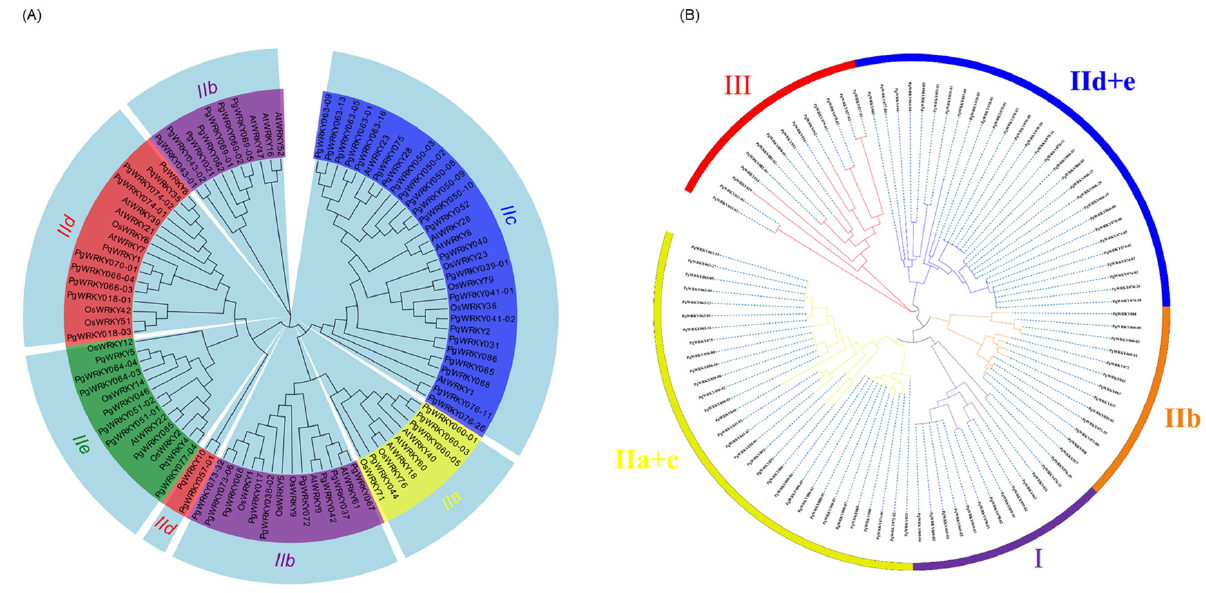
Figure 3. Phylogenetic tree of the PgWRKY gene family. ( A ) The total of 91 PgWRKY genes in subgroup II that had complete ORFs and were used as representatives to construct the classification and phylogeny with 3 other species 53 WRKY genes (Table S3). Yellowish in the inner circle indicates the WRKY genes Group II-a; Purple in the inner circle the WRKY genes Group II-b; Blue in the inner circle the WRKY genes Group II-c; Red in the inner circle the WRKY genes Group II-d; Green in the inner circle the WRKY genes Group II-e. The total of 53 WRKY genes from Arabidopsis thaliana ( AtWRKY ), Oryza sativa ( OsWRKY ), Panax quinquefolium ( PqWRKY ). ( B ) Phylogenetic tree depicting PgWRKY gene family evolution in Panax ginseng . Purple in the outer circle the PgWRKY genes Group I; Yellow in the outer circle the PgWRKY genes Group II-a and -c; Orange in the outer circle the PgWRKY genes Group II-b; Bule in the outer circle the PgWRKY genes Group II-d and -e; Red in the outer circle the PgWRKY genes Group III. The numbers for the branches of the tree are bootstrap confidence out of 2000